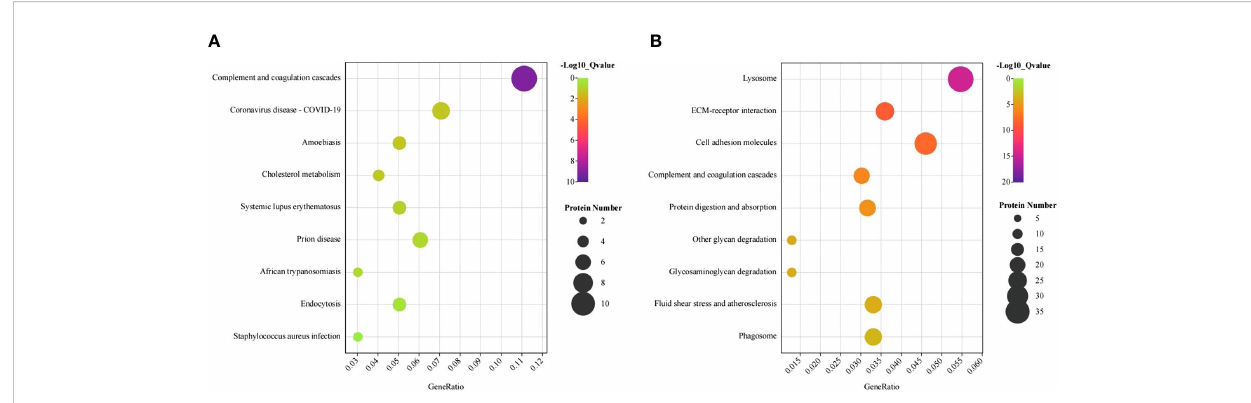
FIGURE 2 KEGG bubble plots of urinary differentially expressed proteins between IgA nephropathy (IgAN) and healthy controls (HC). KEGG bubble plots of urinary differentially expressed proteins up-regulated (A) and down-regulated (B) between IgAN and HC, respectively.